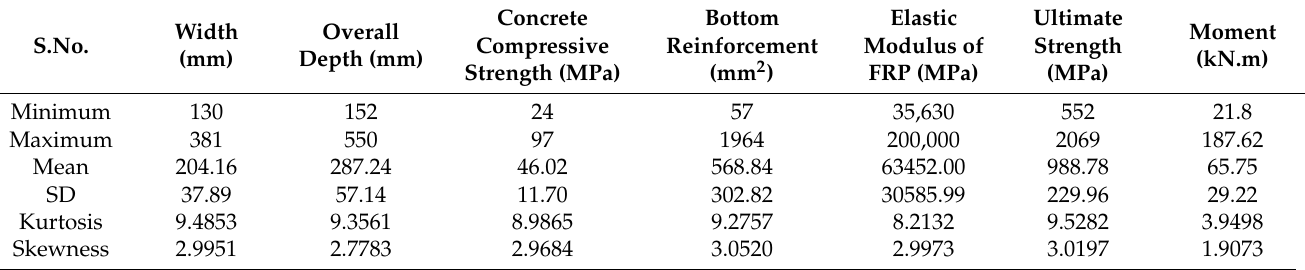
Table 2. Descriptive statistics of input and output variables used in the current